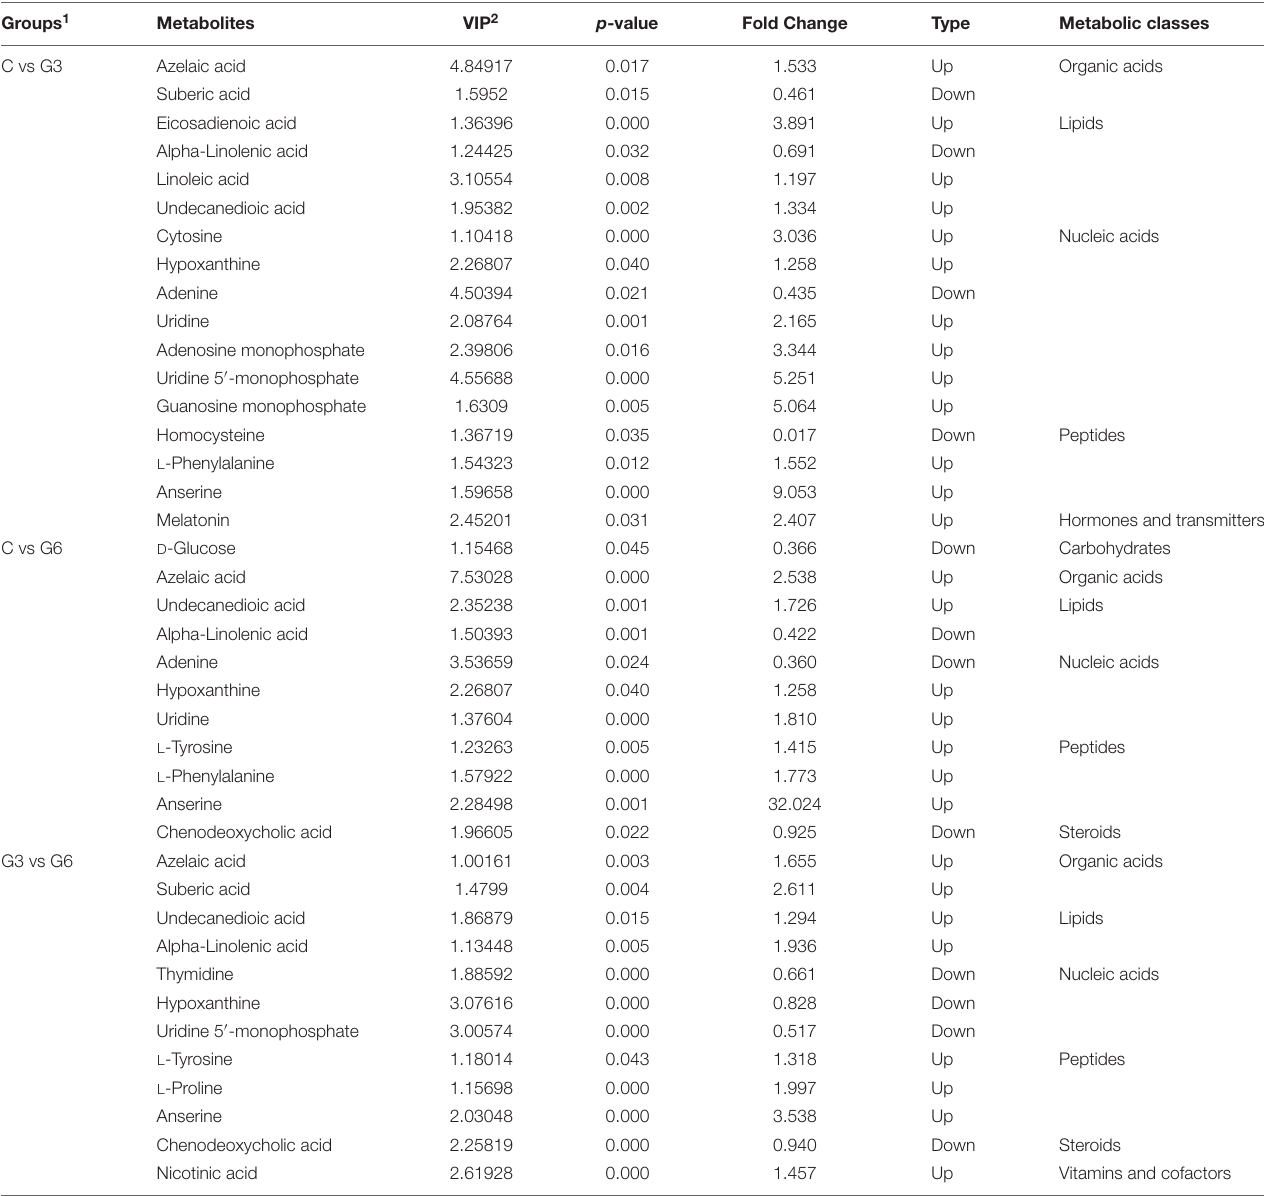
TABLE 1 | Potential distinguishing metabolites in the rumen fluid between three groups. Groups